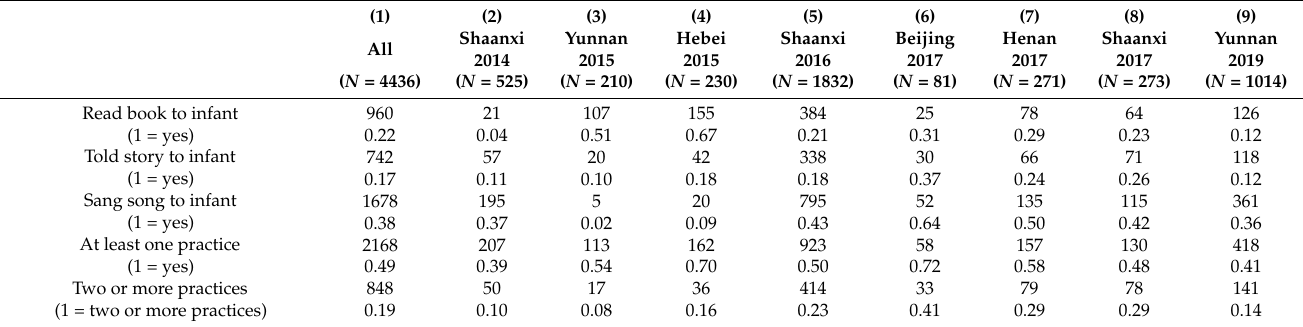
Table 3. Prevalence of stimulating parenting